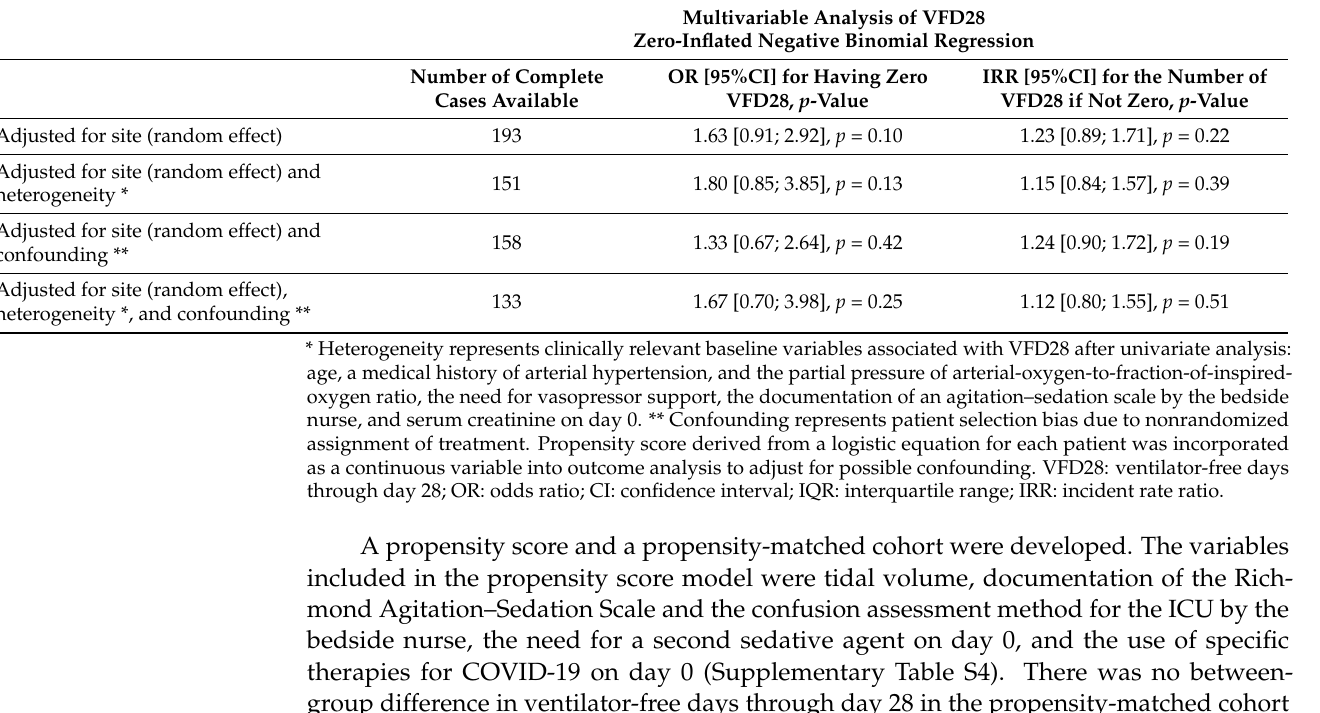
Table 3. Multivariable analyses of ventilator-free days through day 28 using zero-inflated negative binomial